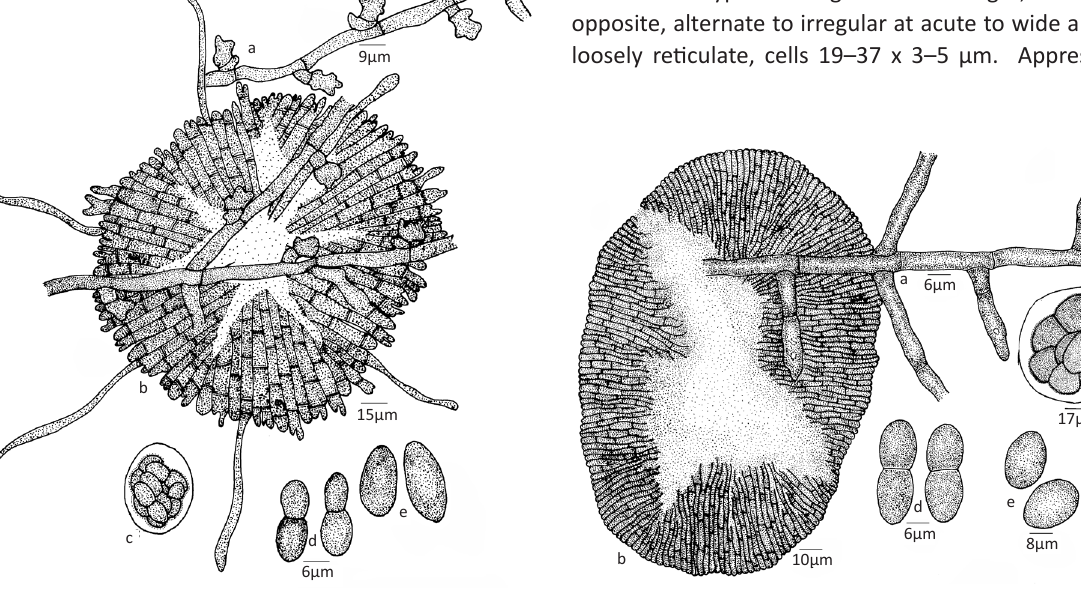
Figure 5. Asterina ushae sp. nov. a - Appressoriate mycelium; b - Thyriothecium; c - Ascus; d -